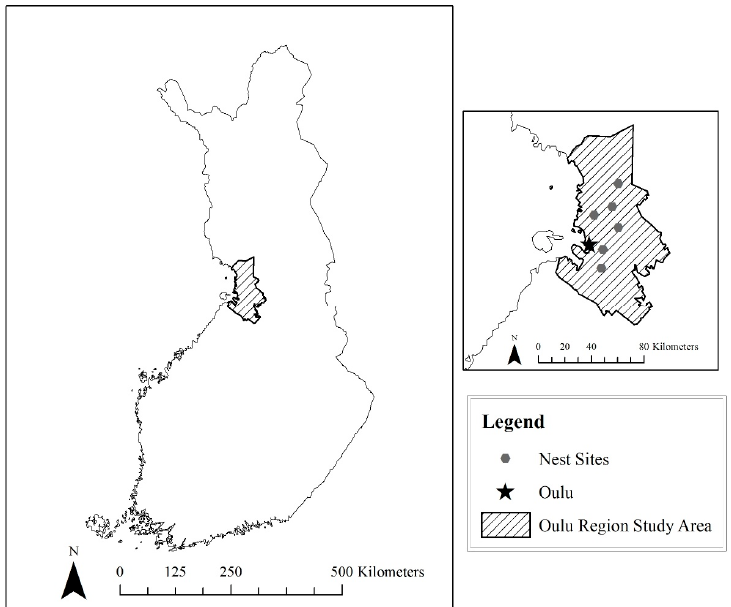
Figure 1. The study area in west-central Finland, near the city of Oulu. Nest sites are approximated locations. Animals 2019 , 9 , x